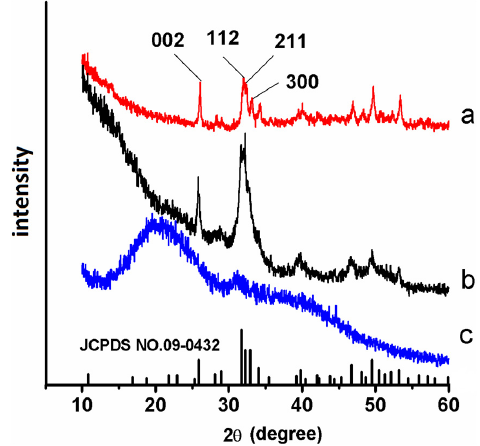
Figure 1. X ‐ ray diffraction (XRD) spectra of the precipitates that were formed on dentin after six cycles of electric field ‐ aided mineralization ( a , red line), XRD spectra of sound dentin ( b , black line) and completely demineralized dentin ( c , blue line).